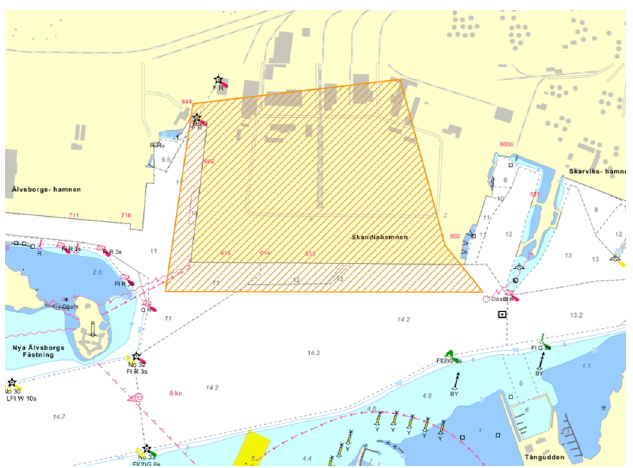
Figure 1. Gothenburg Container Terminal, with a drawn polygon (in orange) defining the relevant port area.